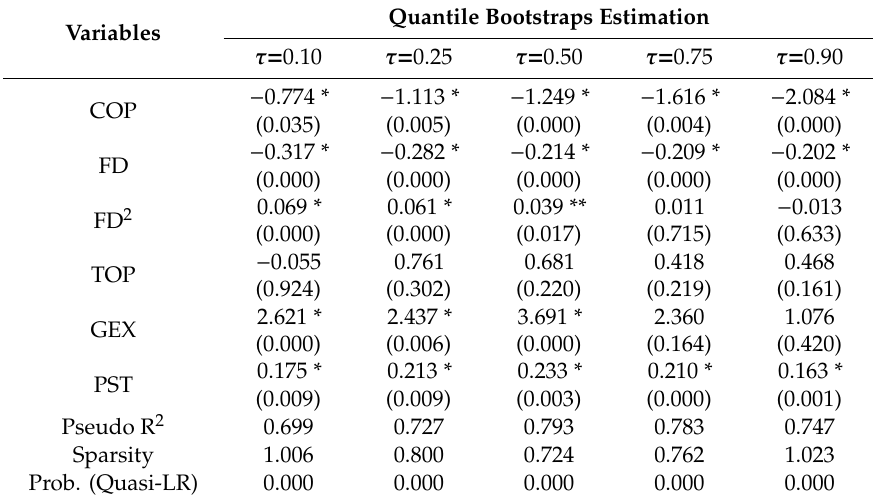
Table 8. The bootstrap quantile